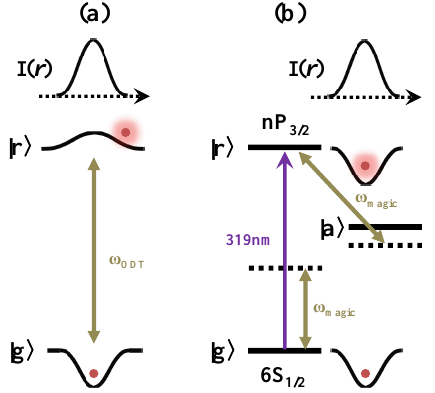
Figure 2. Trapping of Rydberg atoms. ( a ) The conventional far-off-resonance red-detuned ODT is attractive for ground states but usually repulsive for highly excited Rydberg states. ( b ) The direct single-photon transition from | g (cid:105) = | 6 S 1/2 (cid:105) to | r (cid:105) = | nP 3/2 (cid:105) coupled by a 319-nm ultraviolet laser. The trapping potential of the | g (cid:105) and | r (cid:105) states can be equalized when an ODT laser is tuned to the blue side of the | r (cid:105) ↔ | a (cid:105) auxiliary